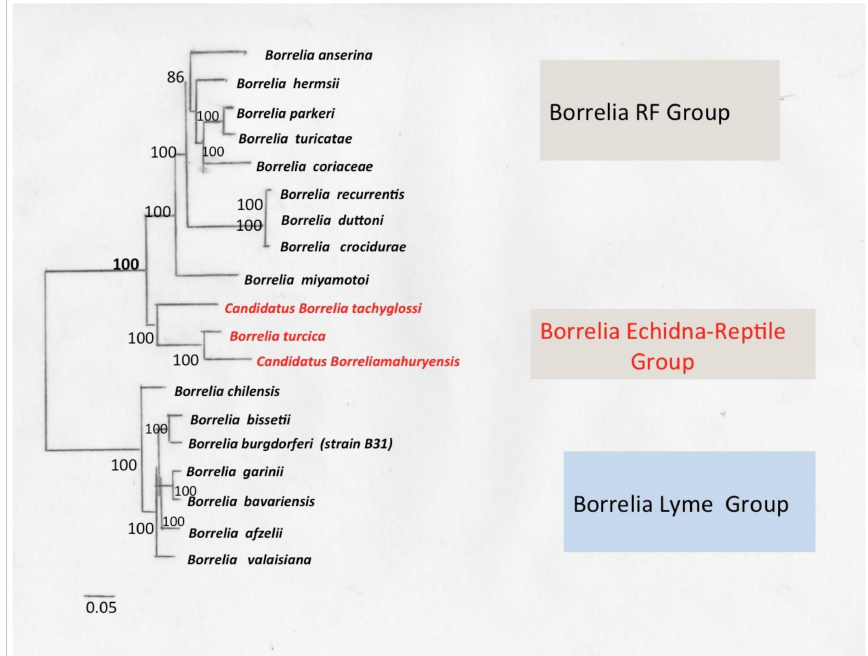
Figure 1. Phylogenetic relationship of 19 Borrelia genomes. The phylogenetic tree was inferred using maximum likelihood analysis of a concatenated alignment of 590 single-copy orthologous genes (197,675 AA). The number on each node represents the support of 1000 bootstrap replicates. The Echidna-Reptile group is shown in red. Elaborated from data of Binetruy et al. [56] (image by M.